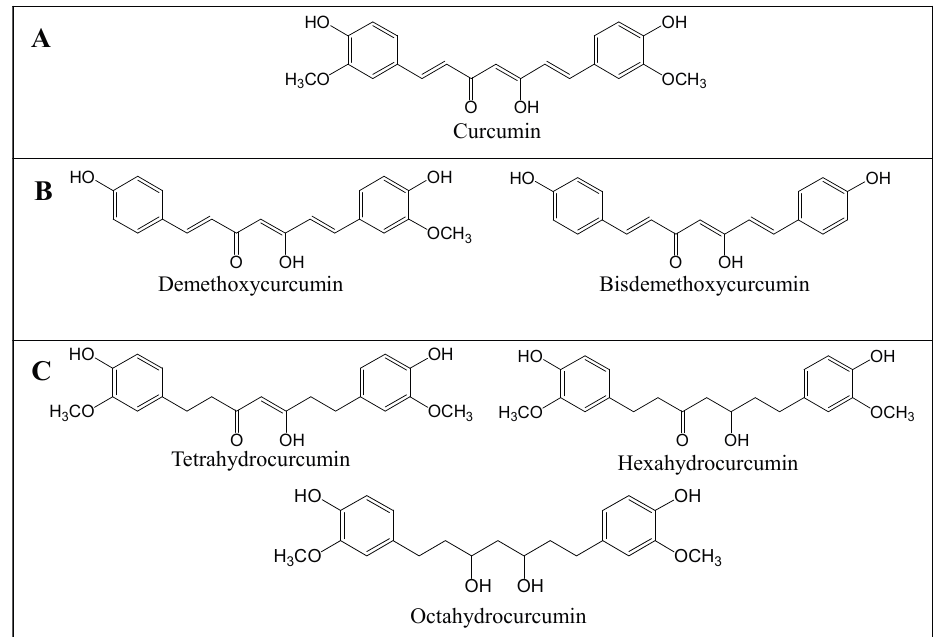
Figure 1. Chemical structure of curcuminoids. Curcumin ( A ); Curcumin demethoxy derivatives (demethoxycurcumin and bisdemethoxycurcumin) ( B ); Hydrogenated curcumin metabolites (tetrahydrocurcumin, hexahydrocurcumin and octahydrocurcumin) ( C